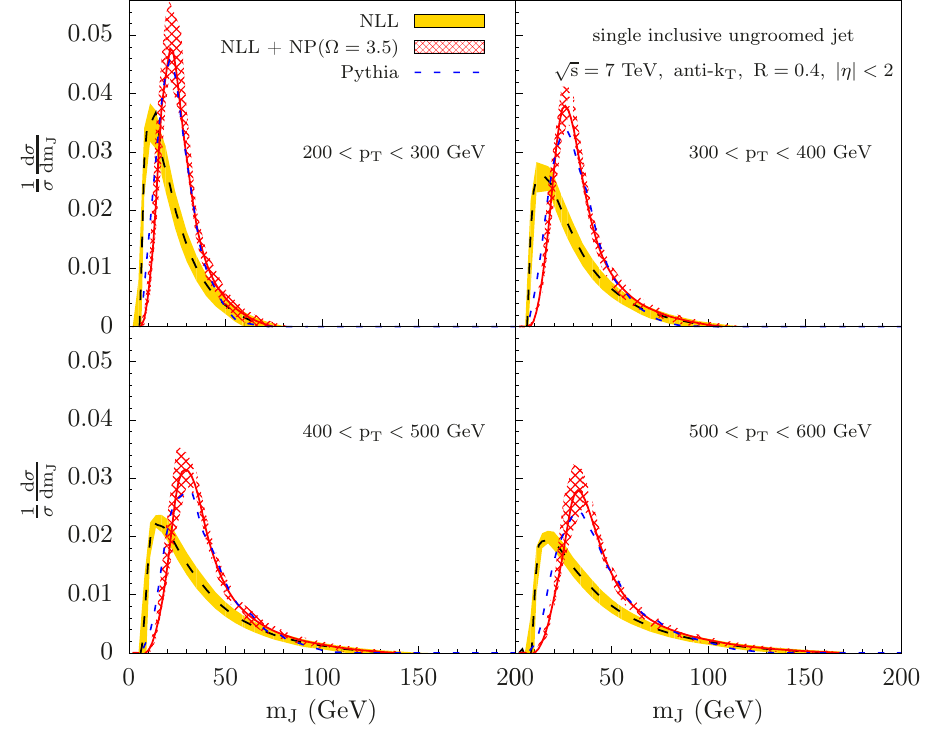
Figure 5 . Same as for (cid:12)gure 4, but for jets with R = 0 : 4. The parameter of the non-perturbative shape function is chosen as (cid:10) = 3 : 5 GeV, to agree better with the Pythia8 results.